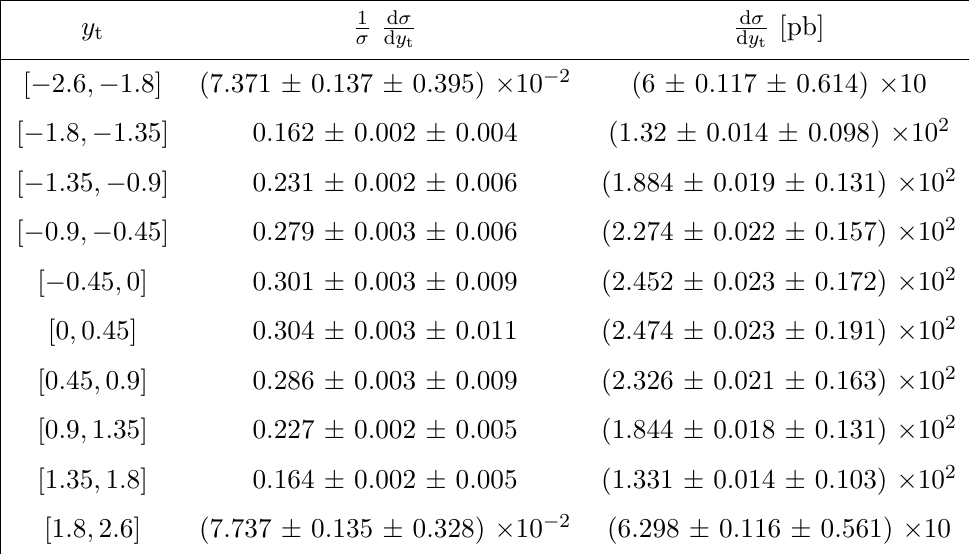
Table 6 . The measured di(cid:11)erential cross section and bin boundaries for each bin of the normalized and absolute measurements of the tt di(cid:11)erential cross section at parton level in the full phase space as a function of y t are